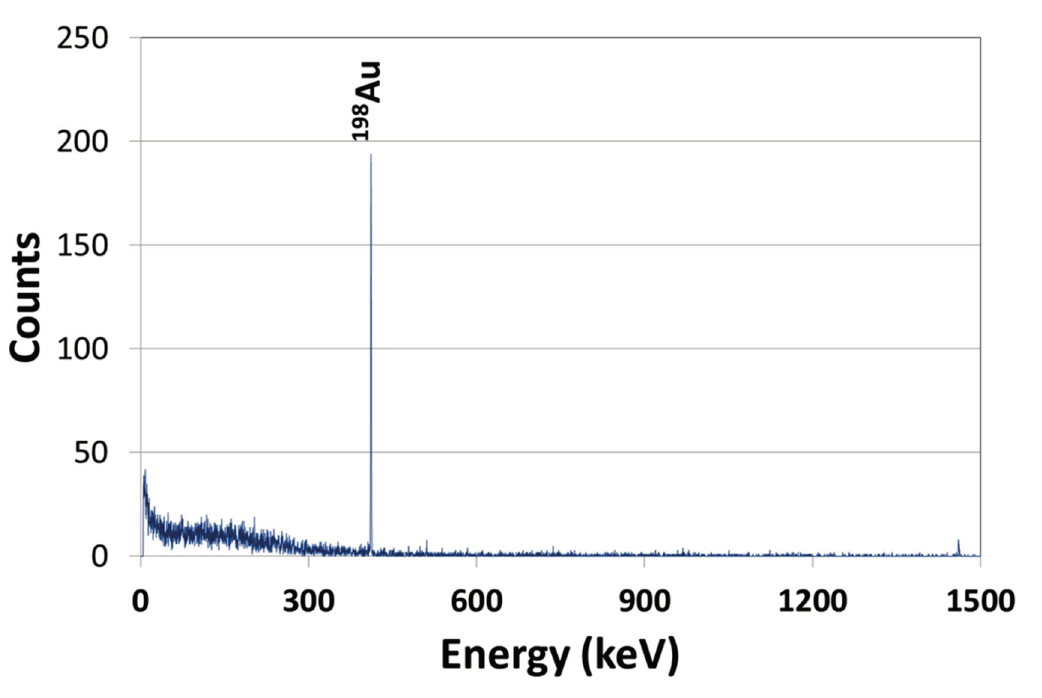
Figure 3. Gamma spectrum of the radioactive gold nanoparticles used in the animal